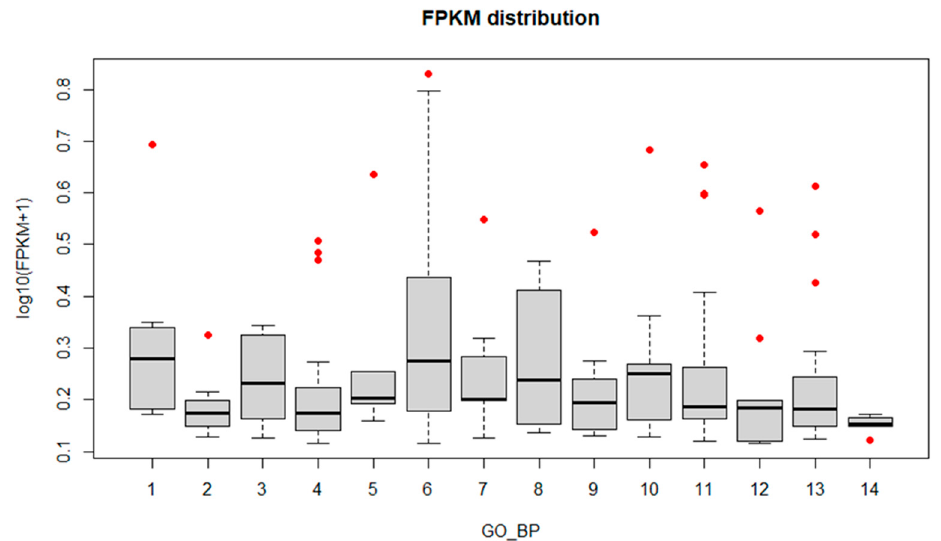
Figure 6. FPKM distribution of the most enriched GO terms (Biological Process). The x -axis corre- sponds to the enriched terms with more than five Unigenes, the y -axis is the FPKM value expressed as log 10 (FPKM+1) (FPKM > 0.3). Red dots represent the ”outlier” clusters. 1: proton transmembrane